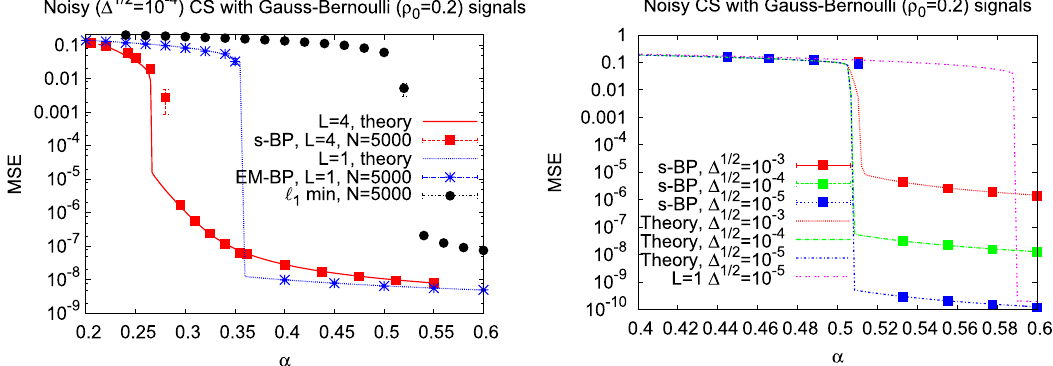
FIG. 8. Mean-squared error as a function of (cid:1) for different values of the measurement noise. Left: Gauss-Bernoulli signal with ¼ 0 : 2 , and measurement noise with standard deviation (cid:2) 0